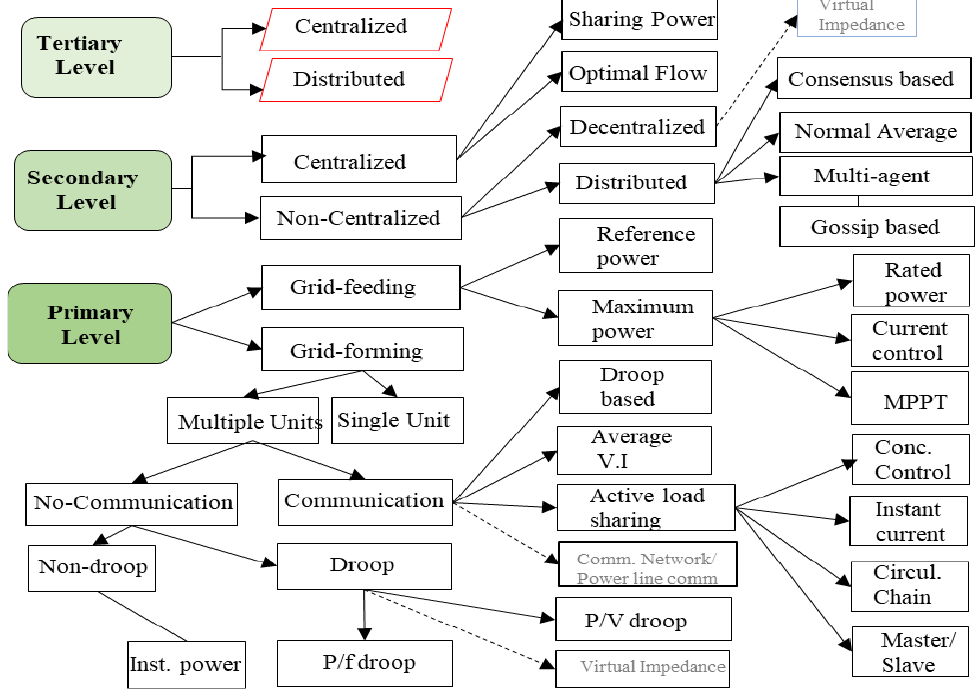
Figure 8. The categorization of primary, secondary and tertiary control levels.